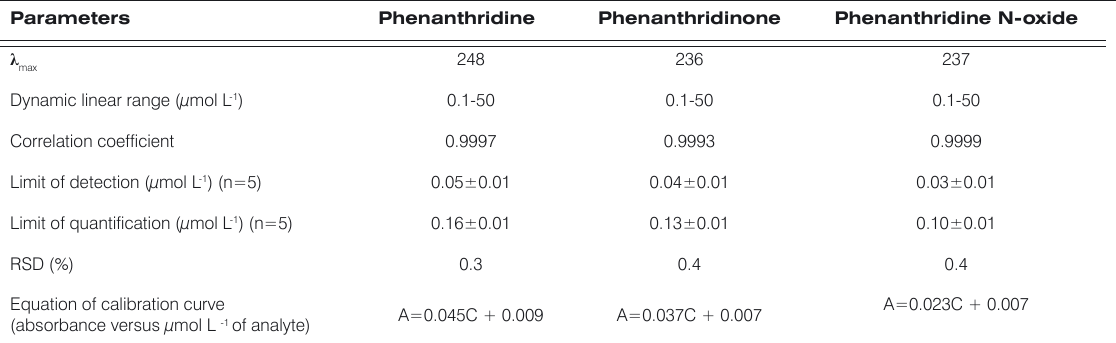
Table 1. Analytical figures of merit for phenanthridine, phenanthridinone and phenanthridine N-oxide